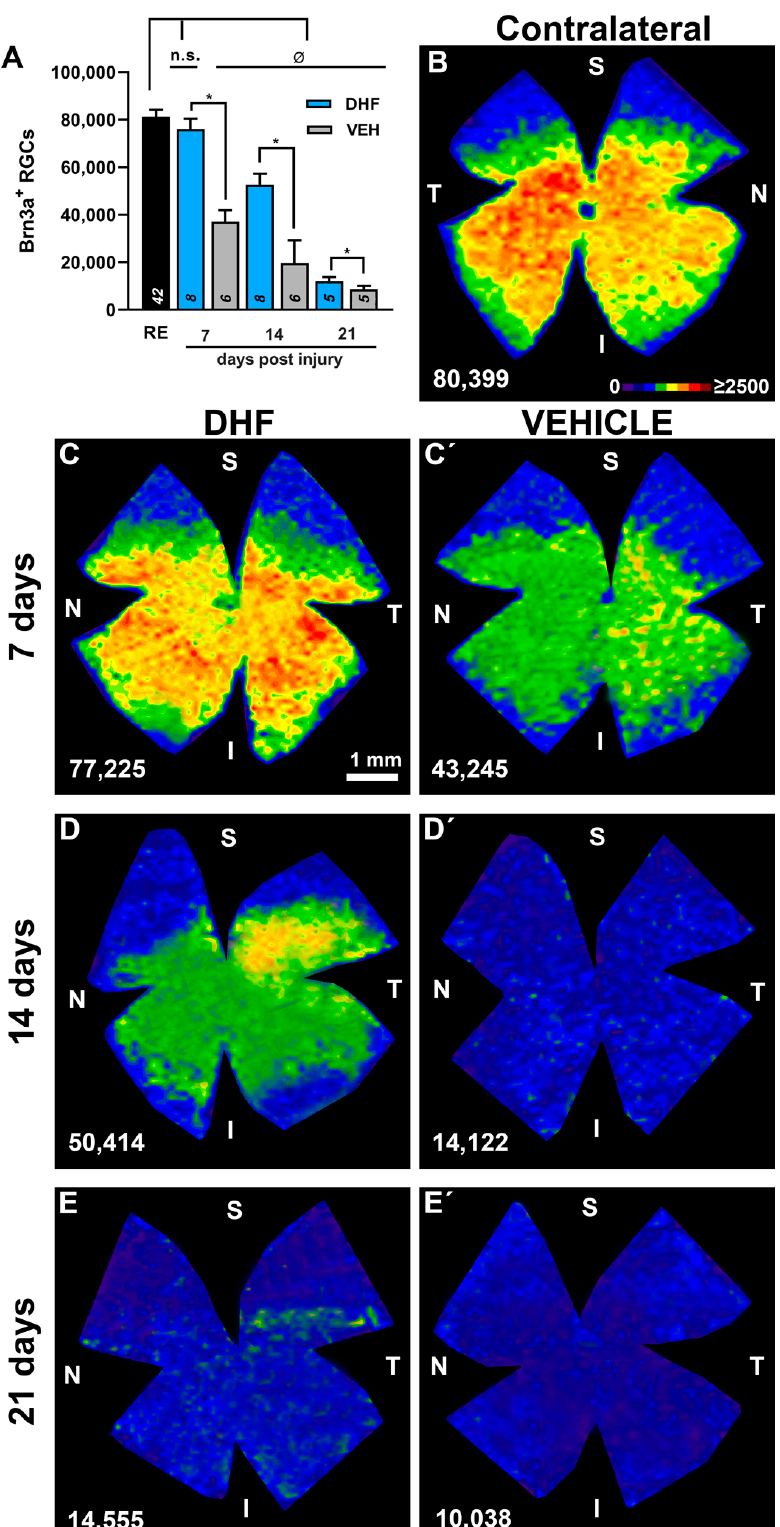
Figure 3. DHF prevents IONT-induced Brn3a+RGC loss. In adult albino rats, the left optic nerve was intraorbitally transected and animals were treated i.p. daily with vehicle (VEH) (1% DMSO in 0.9% NaCl) or DHF (5 mg/kg) starting one day before IONT until processing and analyzed at 7, 14 or 21 days post injury to determine Brn3a+RGC survival. ( A ) Bar histogram showing mean